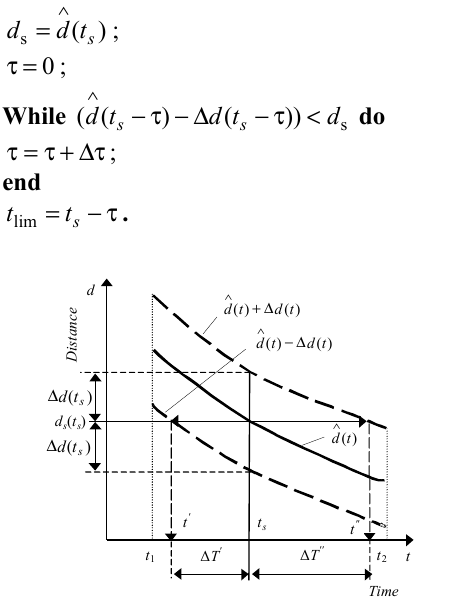
Fig 2. Transformation of the confidence distance interval to the confidence time